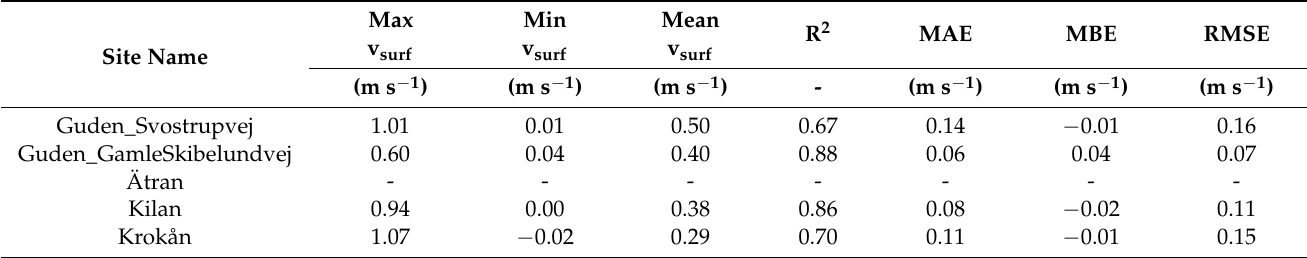
Table 2. Comparing the surface velocity (v surf ) measurements retrieved with PIV and ground- truth (MFpro for all XS, apart from Guden_Svostrupvej where ADCP was used). The ground-truth maximum, minimum and mean of v surf values are reported as reference. In Ätran ground-truth measurements were not acquired, thus statistics are not shown. The following statistics comparing PIV and ground-truth measurements are shown: R 2 (coefficient of determination), MAE (Mean Absolute Error), MBE (Mean Bias Error), RMSE (Root Mean Square